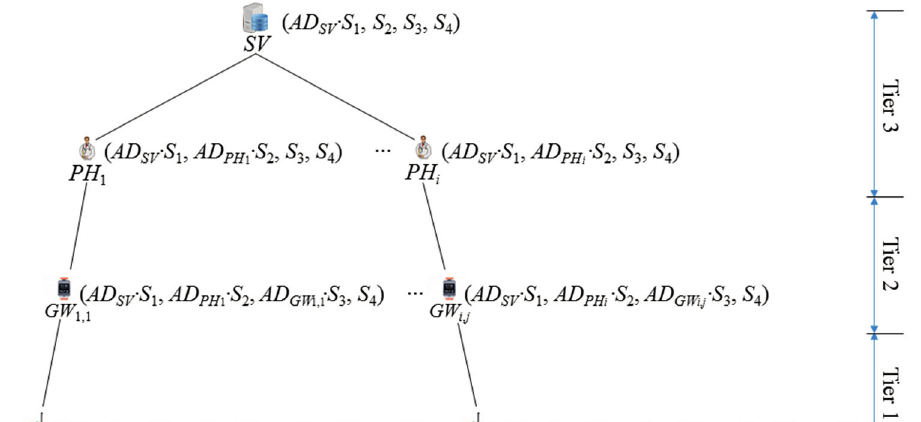
Figure 3. Hierarchical key setup for the freshness-preserving non-interactive hierarchical key agreement protocol